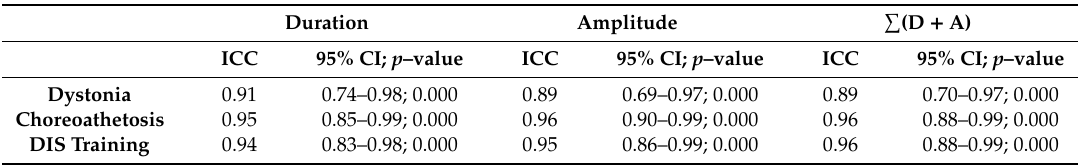
Table A2. Interrater reliability of DIS Training: Intraclass Correlation Coe ffi cients (ICC) with 95% Table 2. Interrater reliability of DIS Training: Intraclass Correlation Coefficients (ICC) with 95% confidence interval (CI) between three raters for the total confidence interval (CI) between three raters for the total scores.